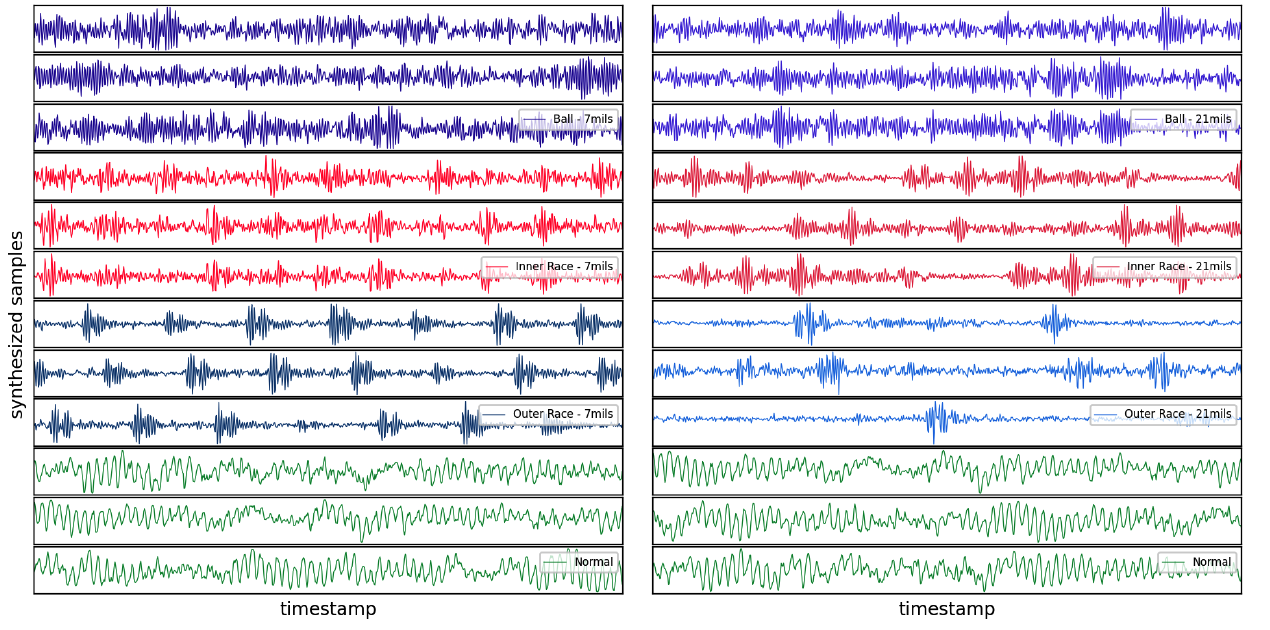
Figure 10. Some random synthesized samples associated with different running conditions made by WGAN-GP.